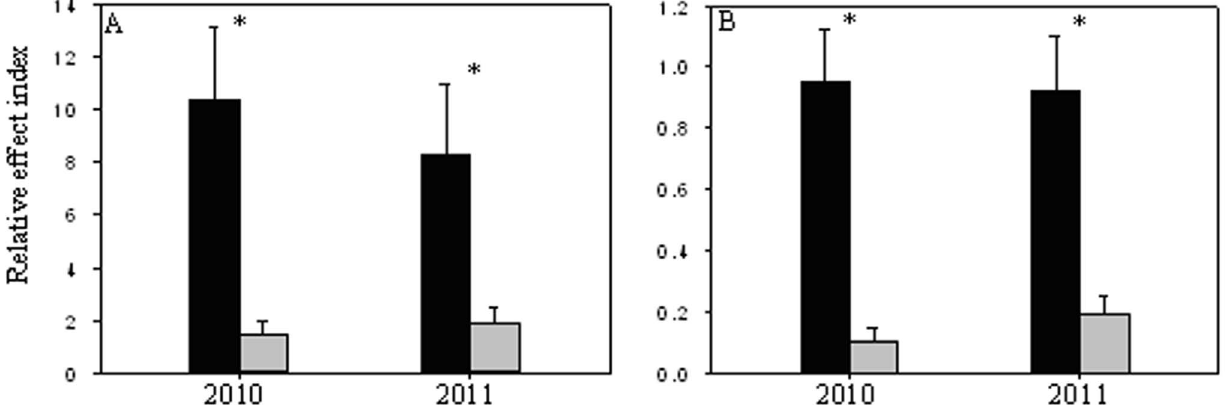
Figure 4. The relative effect index (REI) IV of invaders for coverage (A) and seedling number (B) in the pots dominated by same functional group and the pots dominated by other functional group in 2010 and 2011. Higher values of REI indicate more positive effect of fertilization on the colonization of invaders. *indicate significant difference between the pots dominated by same functional group and the pots dominated by other functional group. The legends are as given in Figure 3. doi:10.1371/journal.pone.0077220.g004 PLOS ONE |